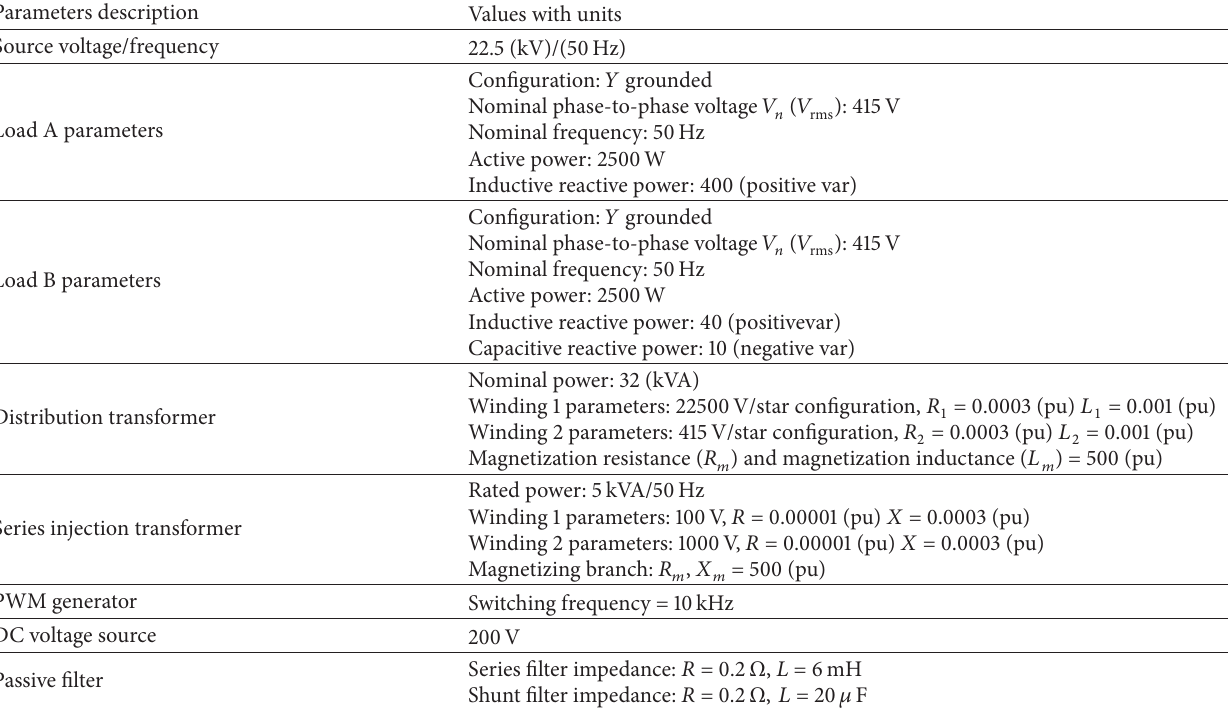
Table 9: Summary of design specifications for the test